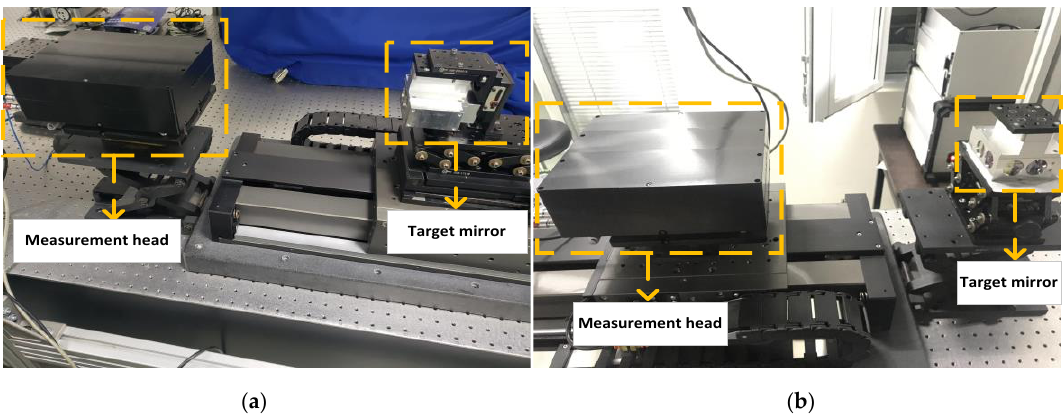
Figure 5. Linear axis motion errors measurement experiment for the two measurement modes. ( a ) Measurement mode 1; ( b ) Measurement mode 2.